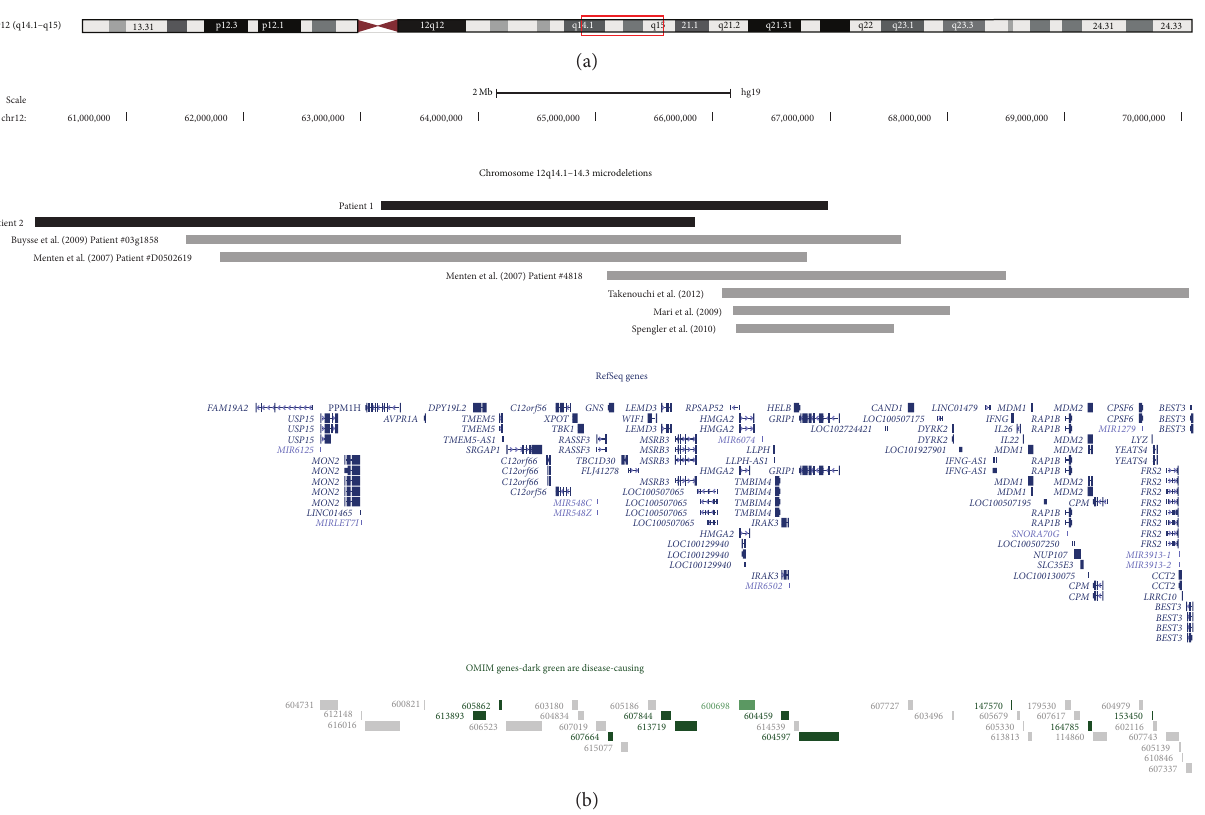
encompassing 14 OMIM genes ( USP15 , MIRLET7I , AVPR1A , DPY19L2 , TMEM5 , SRGAP1 , XPOT , TBK1 , RASSF3 , GNS , TBC1D30 , WIF1 , LEMD3, and part of MSRB3 ). The